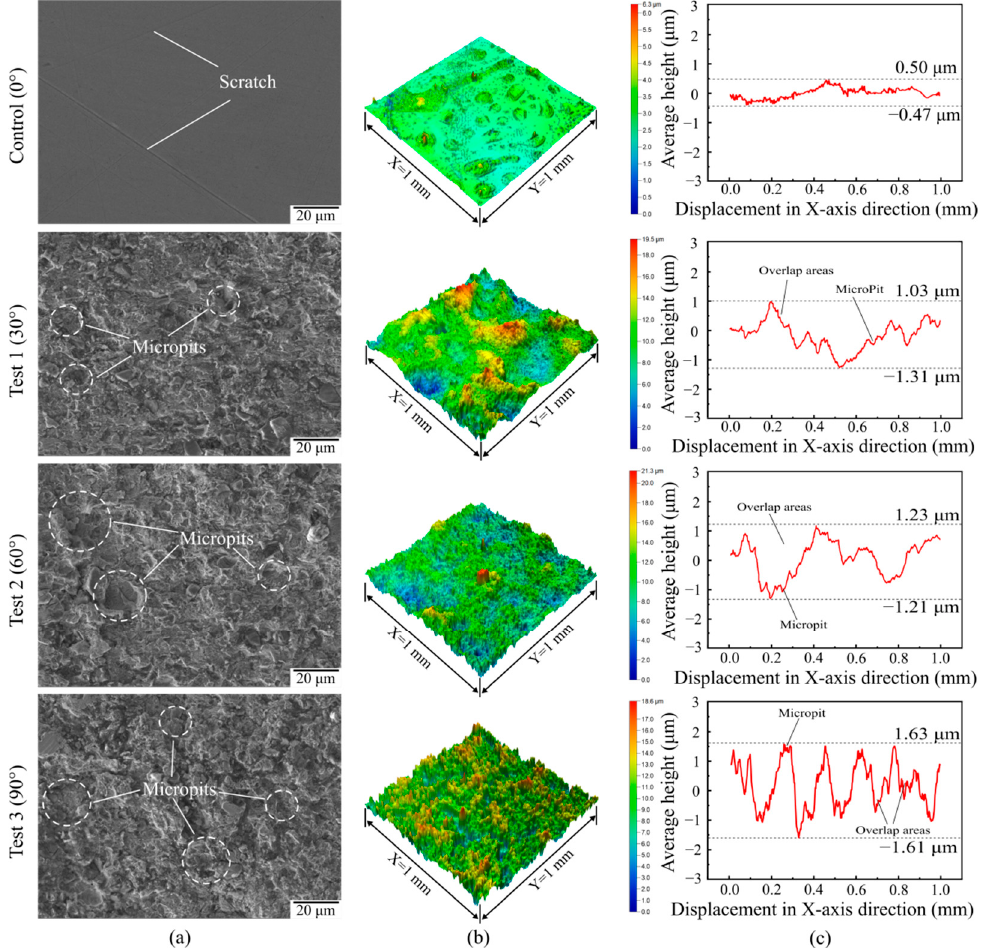
Figure 4. ( a ) SEM maps of surface microstructure versus jet angle; ( b ) three-dimensional morphol- ogy at different jet angles; ( c ) two-dimensional profile at different jet angles. at different jet angles; ( c ) two-dimensional profile at different jet